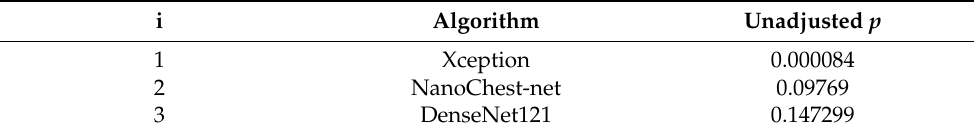
Table 12. Adjusted p-values for time per example obtained through the post hoc method